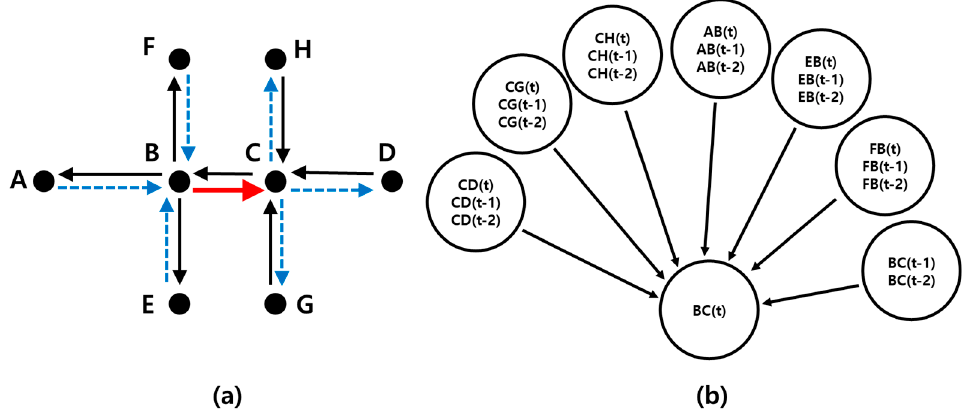
Figure 2. Road network and Bayesian network designed to predict road speeds. ( a ) Example of a road network. ( b ) Bayesian network designed to predict road BC.